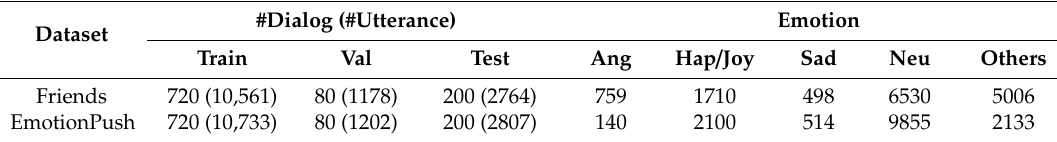
Table 1. Detailed descriptions of Friends and EmotionPush.